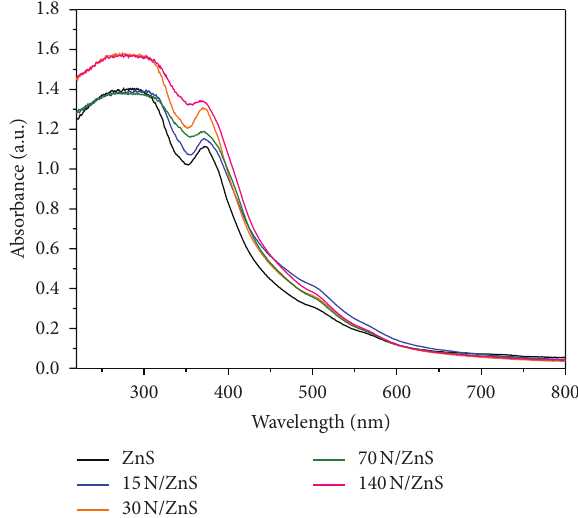
Figure 4: UV-Vis absorption spectra of as-synthesized photocata-